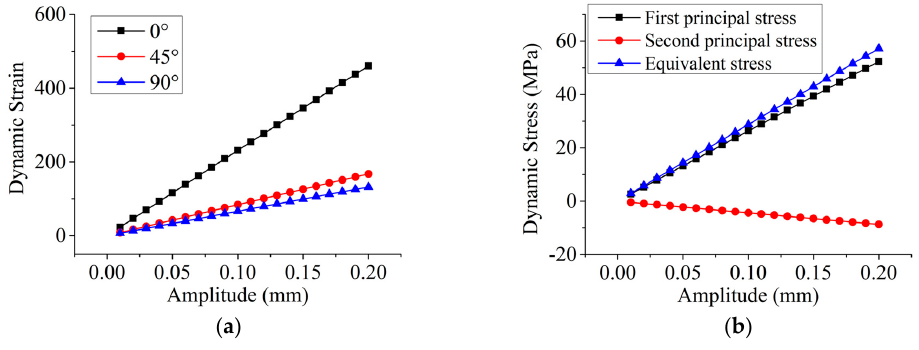
Figure 8. Dynamic stress and strain under different amplitudes: ( a ) dynamic strain; and ( b ) dynamic stress.